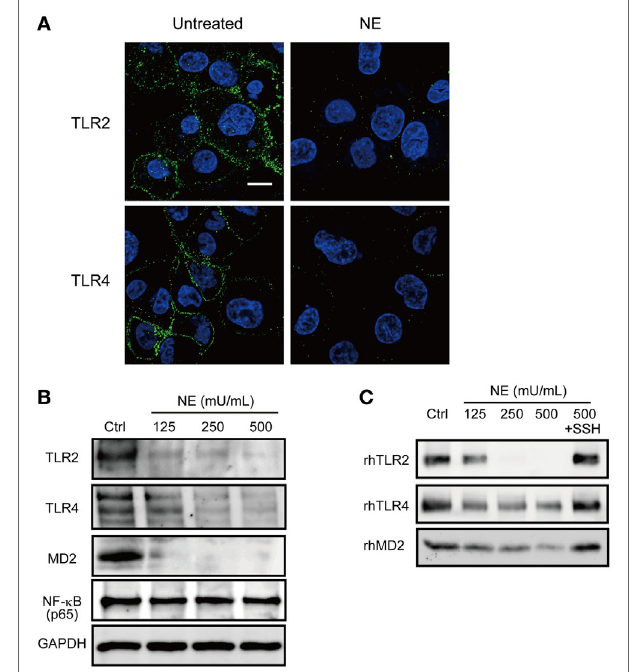
FigUre 3 | Neutrophil elastase (NE) cleaves TLRs and MD2 on macrophages. (a,B) THP-1-derived macrophages were cultured in serum free RPMI 1640 and exposed to hNE (125–500 mU/mL) for 4 h. (a) Representative fluorescence microscopy images of untreated and hNE-treated (500 mU/mL) macrophages stained for DNA (DAPI; blue) and TLRs (green). (B) TLR2, TLR4, and TLR-related molecules were determined by western blot analysis. (c) Recombinant human (rh) TLR2, rhTLR4, and rhMD2 were exposed to hNE (125–500 mU/mL) in the presence or absence of SSH (100 µg/mL) for 3 h and determined by western blot analysis. MD2, myeloid differentiation factor 2; hNE, human neutrophil elastase; SSH, sivelestat sodium hydrate; TLR, toll-like receptor.